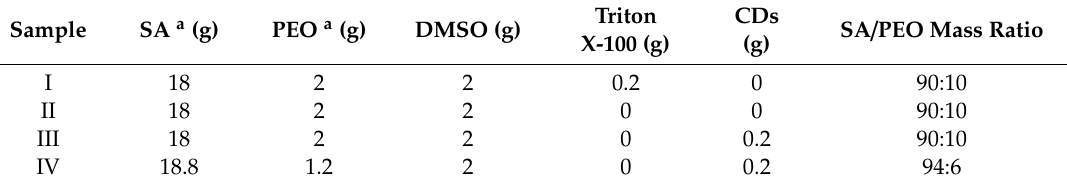
Table 1. The compositions of the spinning